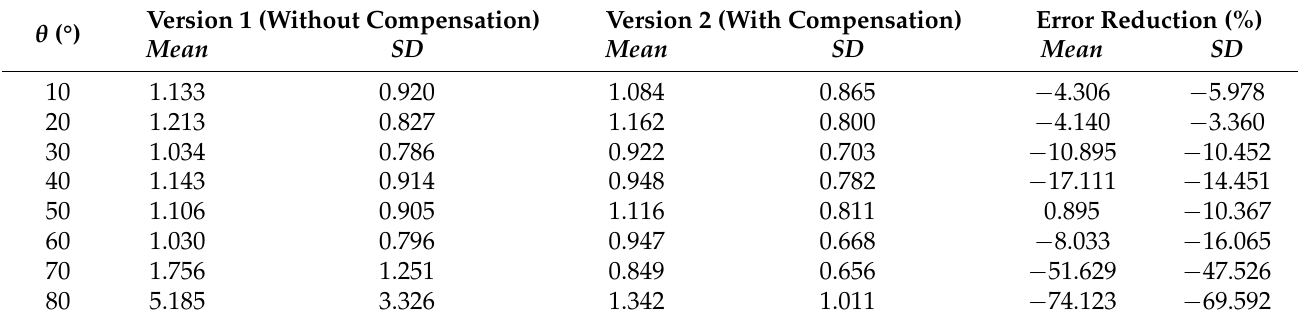
Table 2. The numerical results of direction angle error in 170° FoV camera.